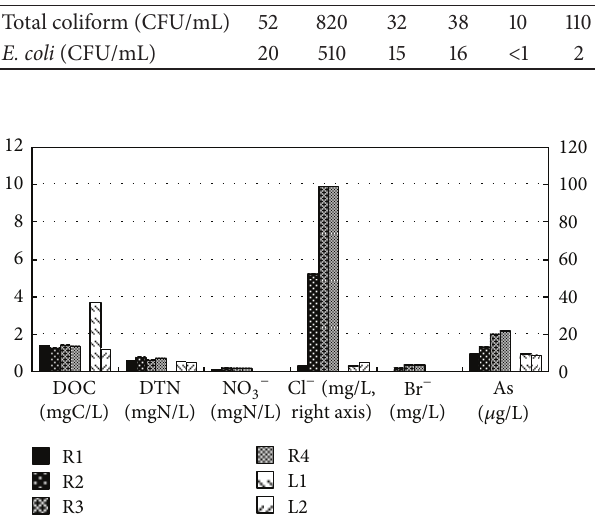
Figure 4: Comparisonof water quality inrivers and lakes at